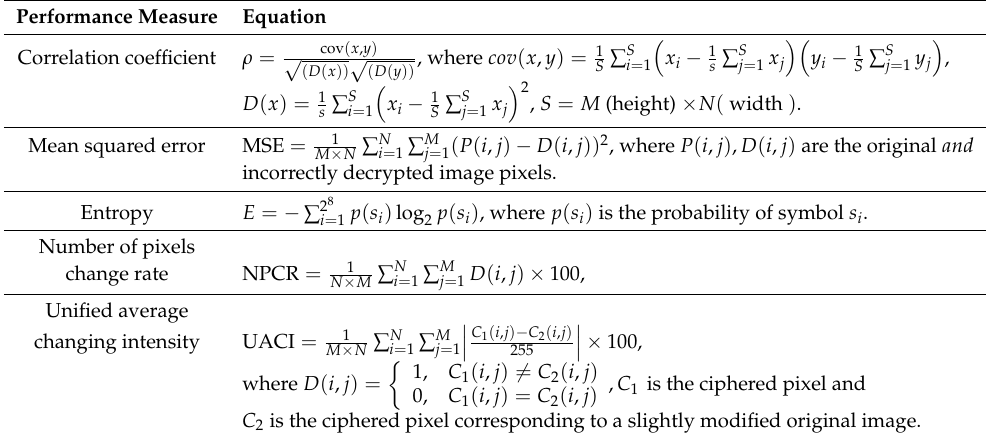
Table 1. Performance metrics of the image encryption systems.